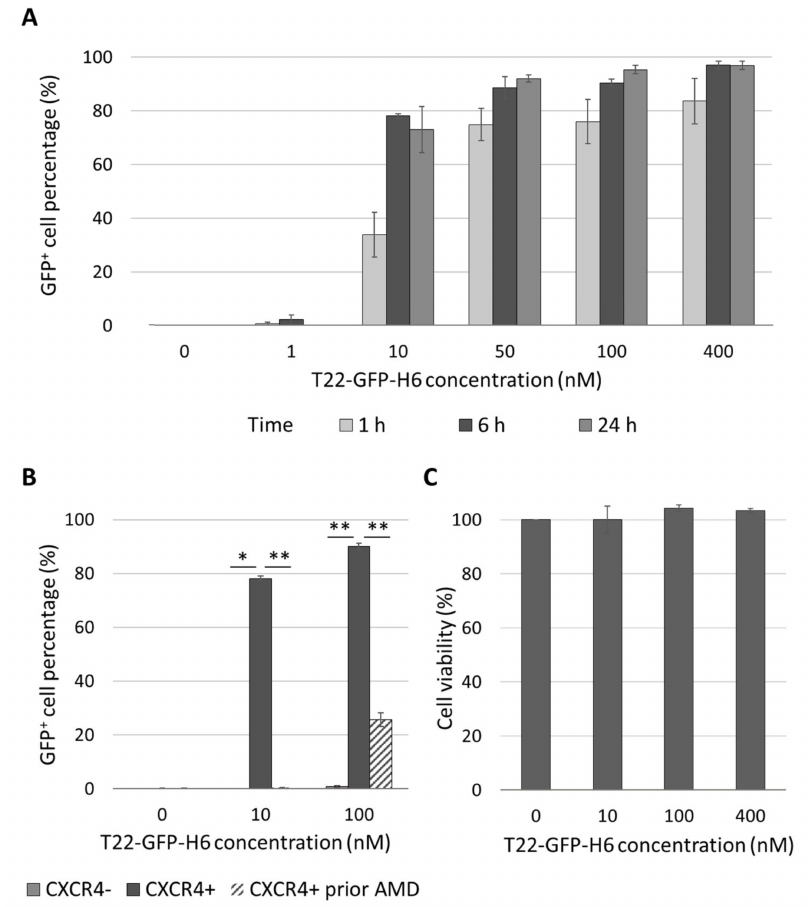
Figure 4. In vitro CXCR4-dependent internalization and lack of cytotoxicity of T22-GFP-H6 nanocar- rier in human endometrial cancer cell line AN3CA. ( A ) T22-GFP-H6 internalization in CXCR4 + AN3CA cells at 1, 6 and 24 h and different concentrations, expressed as percentage of GFP + cells. ( B ) Blockage of T22-GFP-H6 internalization at 6 h, measured by flow cytometry, in CXCR4 - AN3CA cells, CXCR4 + AN3CA cells and CXCR4 + AN3CA cells after 1h pretreatment with 1 µ M of the CXCR4 antagonist AMD3100 (Mann-Whitney test; * p < 0.05, ** p < 0.01; n = 3; mean ± s.e.m). ( C ) T22-GFP-H6 cytotoxicity on CXCR4 + AN3CA cells as measured by XTT viability test at 48 h. ( n = 3; mean ±